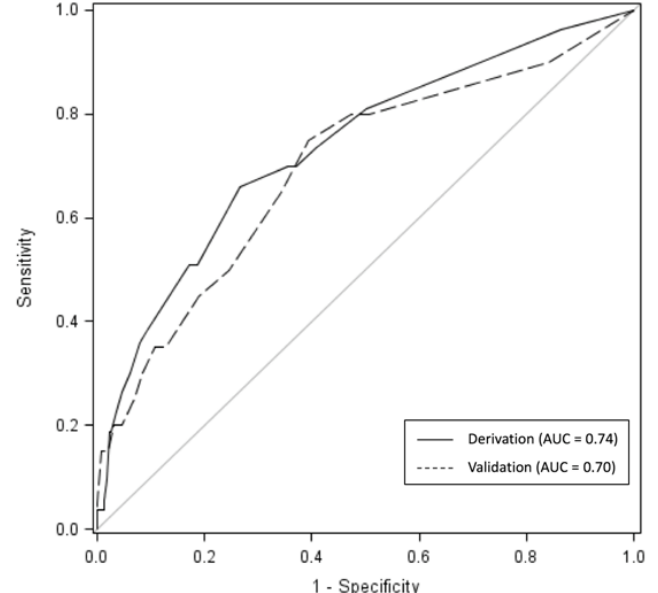
Figure 3. ROC curves demonstrating model performance in Derivation (solid) and Validation (dashed) cohorts. AUC, area under the